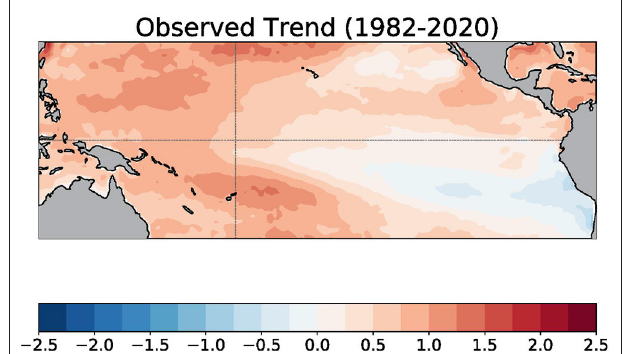
FIGURE 1 | Linear trend of monthly sea surface temperature from January 1982 to December 2020. Units are in degrees Celsius change over January 1982 to December 2020. The thin gray lines indicate the equator and the International Date Line. Data is based on